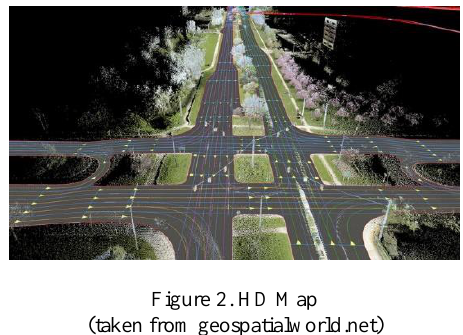
Figure 2. HD Map (taken from geospatialworld.net) HD Maps are 3D, centimeter-level precision, maps produced from survey grade Mobile Mapping Units (MMU) that helps AVs better localize itself and features nearby to make its navigation on the road easier. It is composed of 4 layers: (1) the geometric layer – which contains raw and processed sensor data, (2) the semantic layer – which contains information that can be found on objects and markings, (3) the map prior layer – which contains recorded human behavior patterns in an area, and (4) the real- time layer – which contains real-time traffic data (Vardhan, 2017). Using combinations of those layers makes AVs wiser in times of critical conditions such as: driving on roads